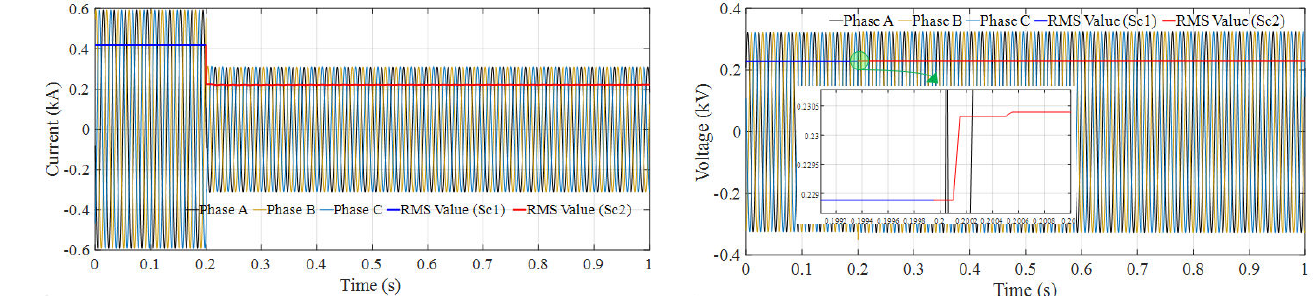
Figure 19. Measured voltage and transformer loading at the secondary side.